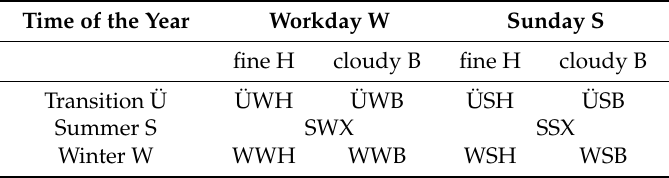
Table 1. Typical-day categories according to VDI 4655 [14]. Time of the Year Workday W Sunday S fine H cloudy B fine H cloudy B Transition Ü ÜWH ÜWB ÜSH ÜSB Summer S SWX SSX Winter W WWH WWB WSH WSB